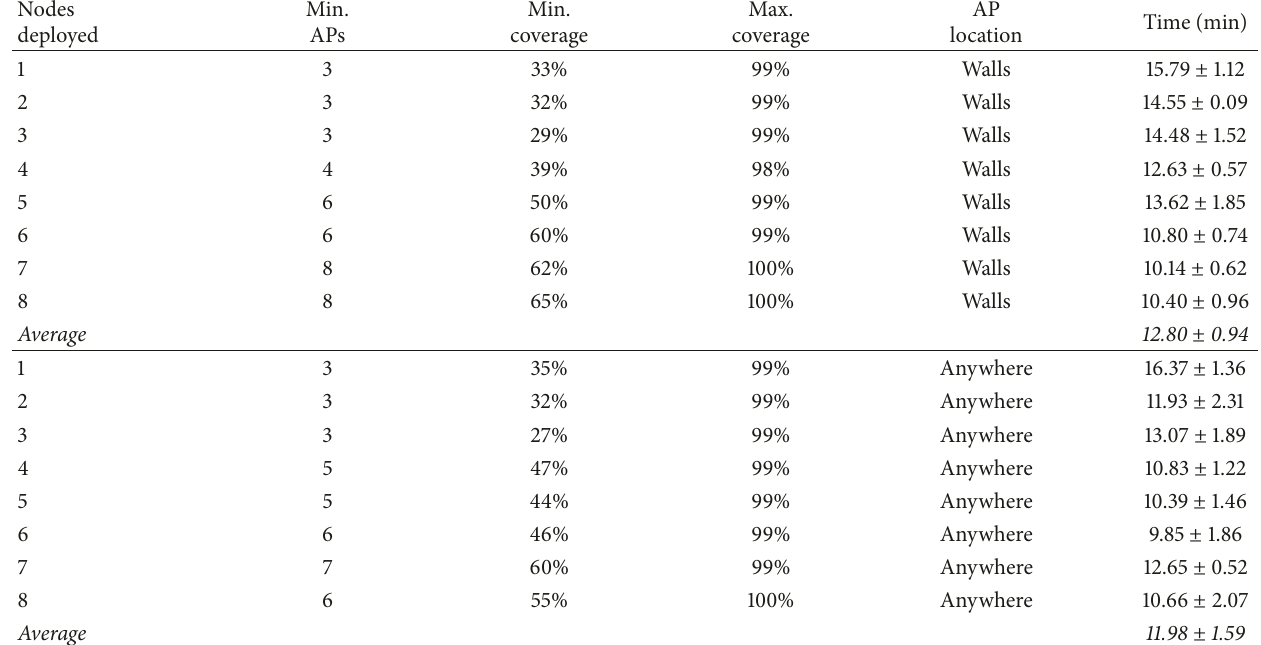
Table 9: Performance of NSGA-II in a large